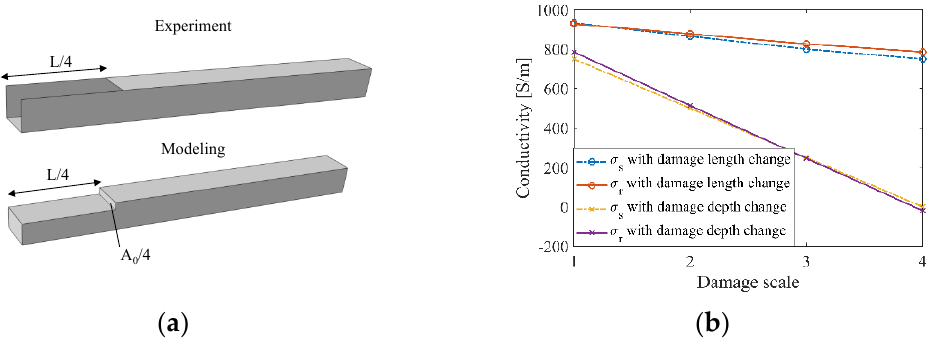
Figure 12. ( a ) The actual experimental damage (Case #1) was compared to what was modeled. ( b ) Representative strut conductivity σ s and reconstructed conductivity in the strut σ r change in tandem as damage increased in severity, both along its length and depth (cross-section).